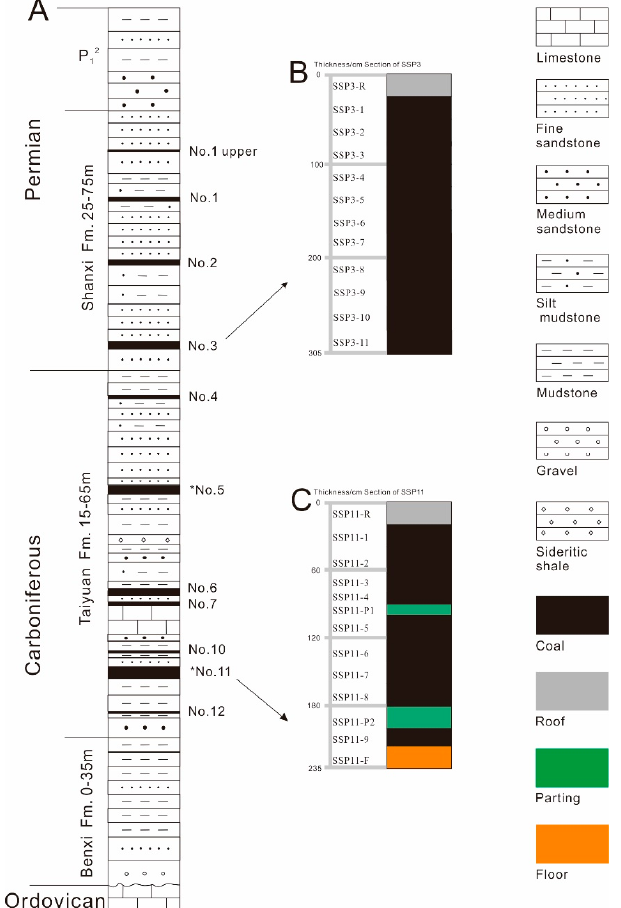
Figure 2. Stratigraphic columns of the Weibei coalfield ( A )and sampling distribution in the No. 3 ( B ) and No. 11 ( C ) coal seam.